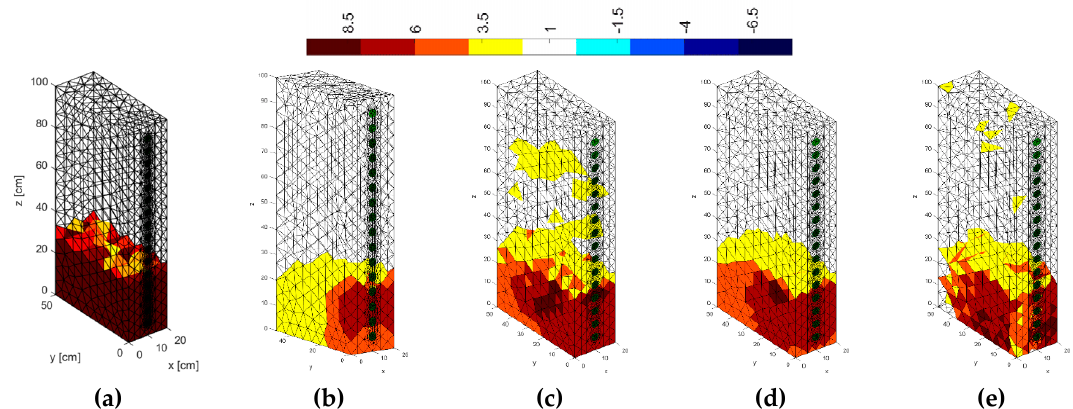
Figure 17. Reconstructions for variant #3: ( a )—Pattern, ( b )—Total Variation, ( c )—LARS, ( d )—Elastic Net, ( e )—ANN.